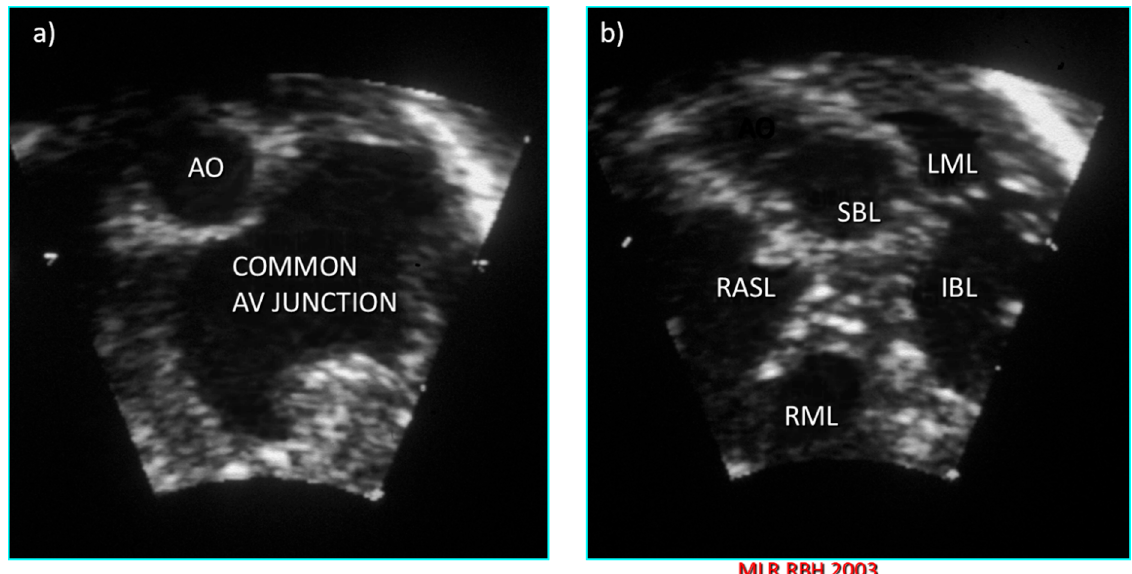
Figure 4. Subcostal left oblique short axis echocardiographic sections of the AV junction showing ( a ) the common atrioventricular junction and ( b ) the five leaflets of the common atrioventricular valve.